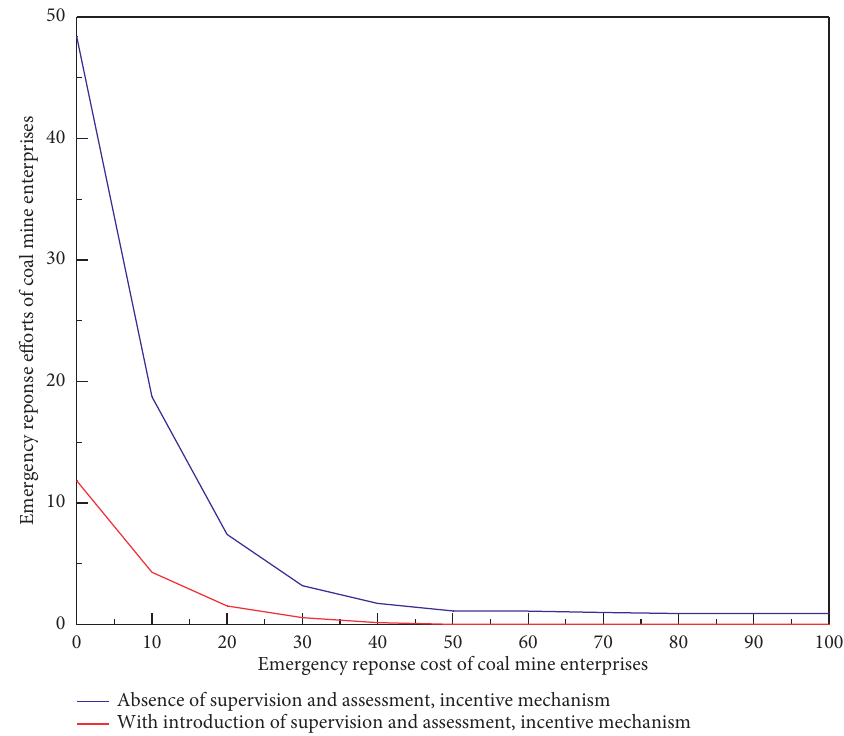
Figure 4: Relationships between emergency response efforts and emergency response costs of coal mine enterprises in two cases.